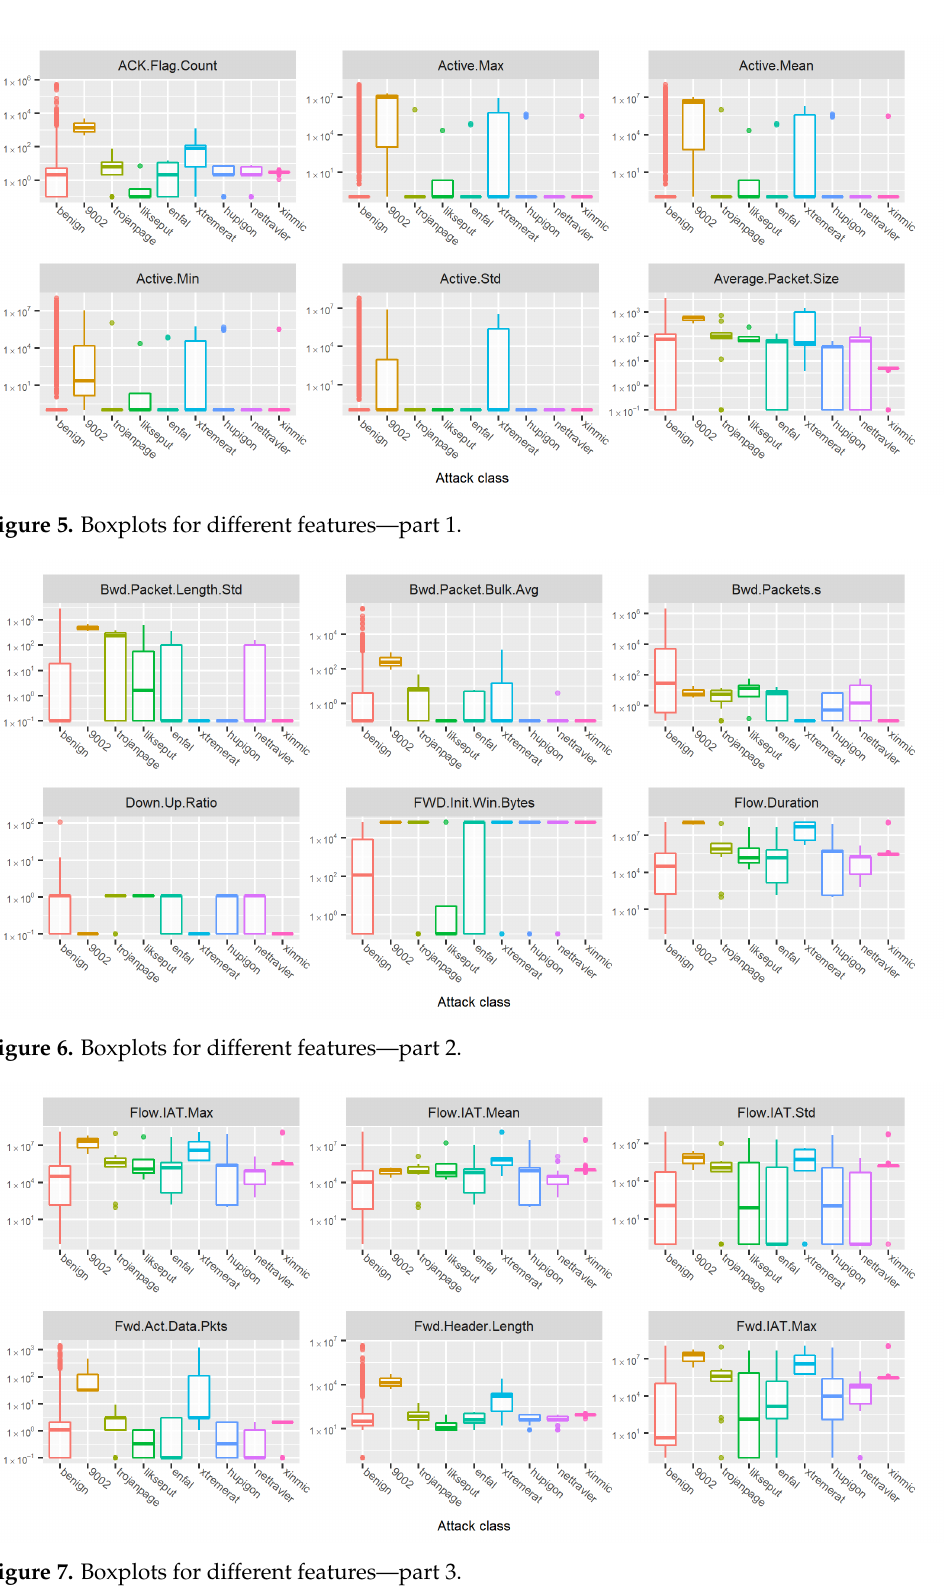
Figure 7. Boxplots for different features—part